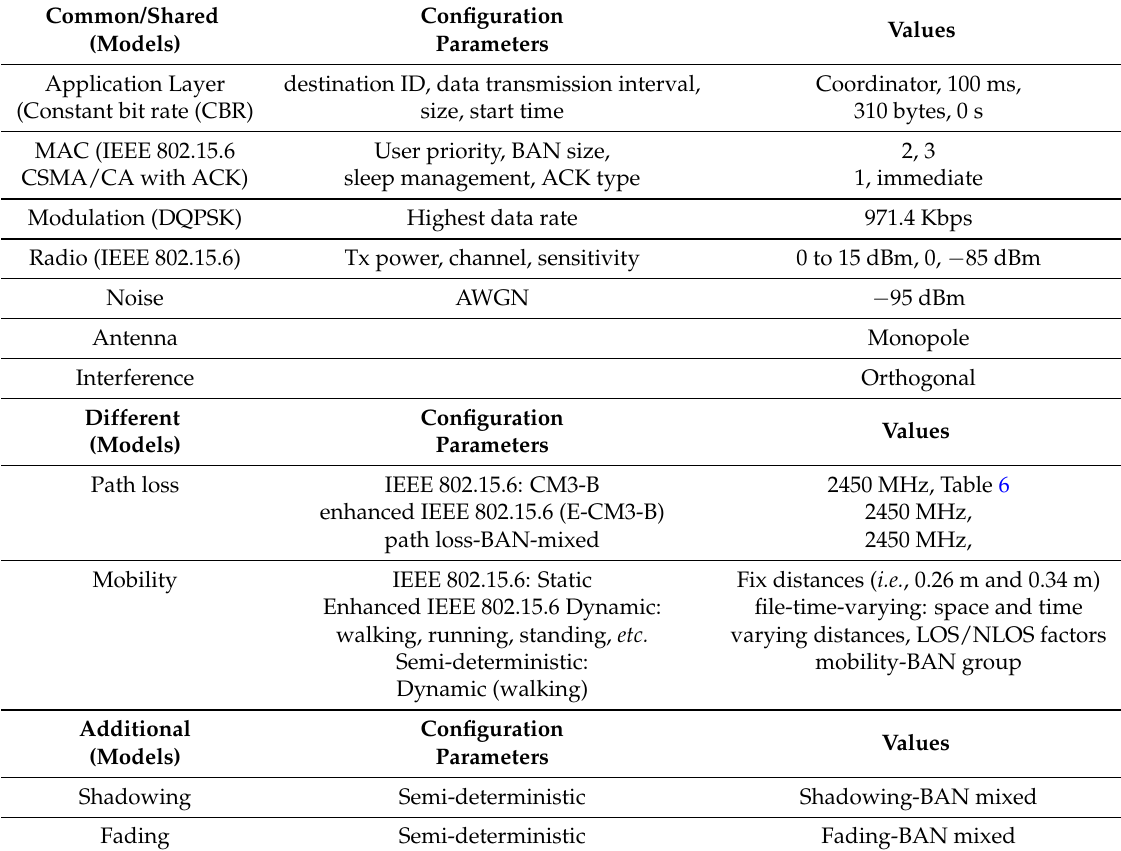
Table 8. Models and their corresponding configurations. DQPSK, differential quadrature phase shift